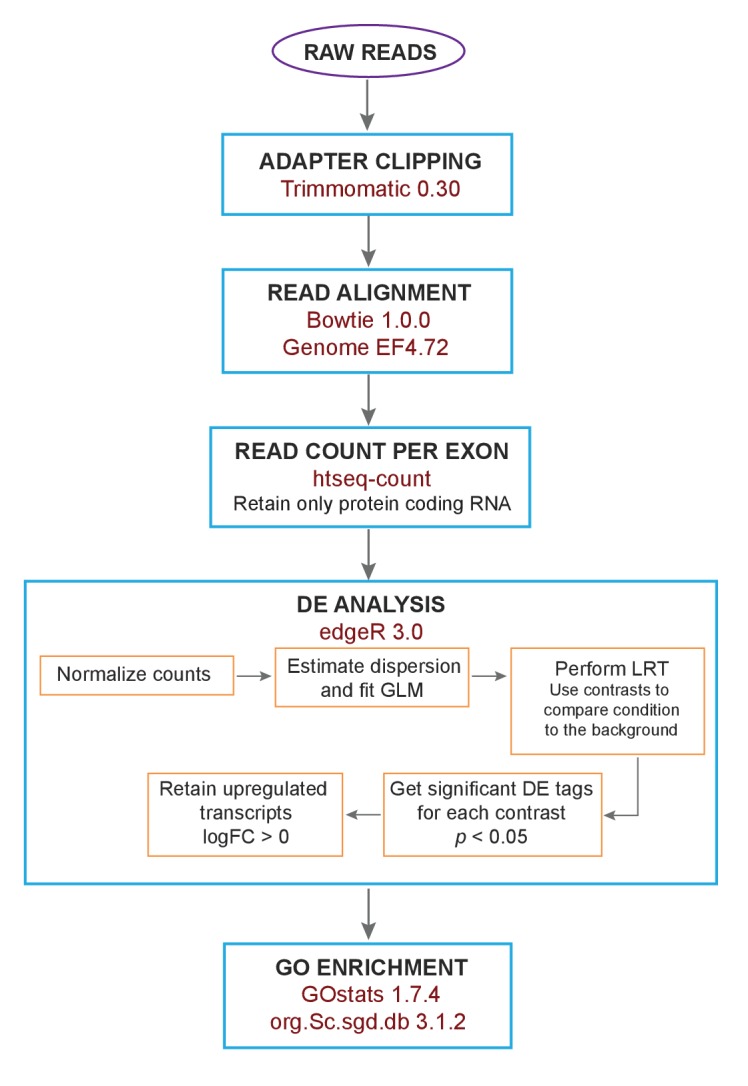
Flow chart of the analysis of RNA-Seq data.The raw reads from the sequencing of RNA-Seq libraries were subject to adapter clipping. Subsequently, the reads were aligned and the read count per exon was extracted. This was followed by differential expression (DE) analysis of only protein coding RNA. Within this step, the counts were normalized, followed by dispersion estimation and fitting of a generalized linear model (GLM). In order to get differentially expressed genes for each stress condition, likelihood ratio tests (LRT) were performed using contrasts to compare the different conditions against the background. The top significant tags (p<0.05) were further filtered using logFC >0 to get significant upregulated genes for each condition.